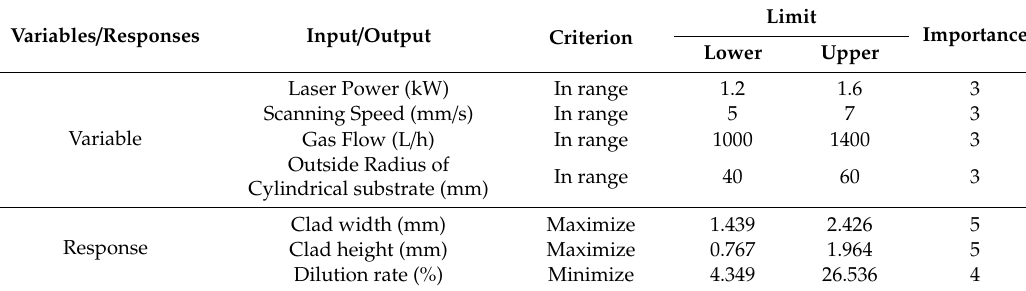
Table 7. Optimization criteria and targets.